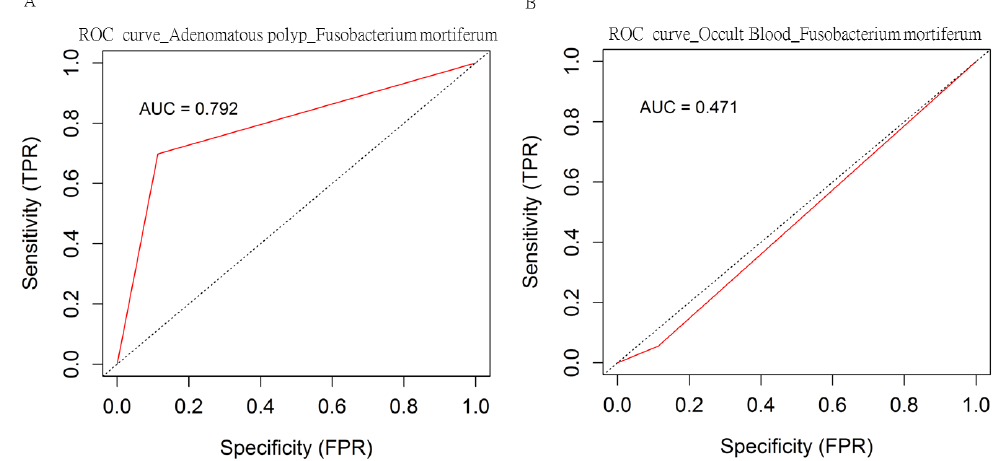
Figure 6. Area under the ROC curve (AUC; red line: ROC curve) for the prediction of ( A ) adenomatous polyp or ( B ) occult blood based on the relative abundance of F. mortiferum in fecal samples with the MinION sequencing results.